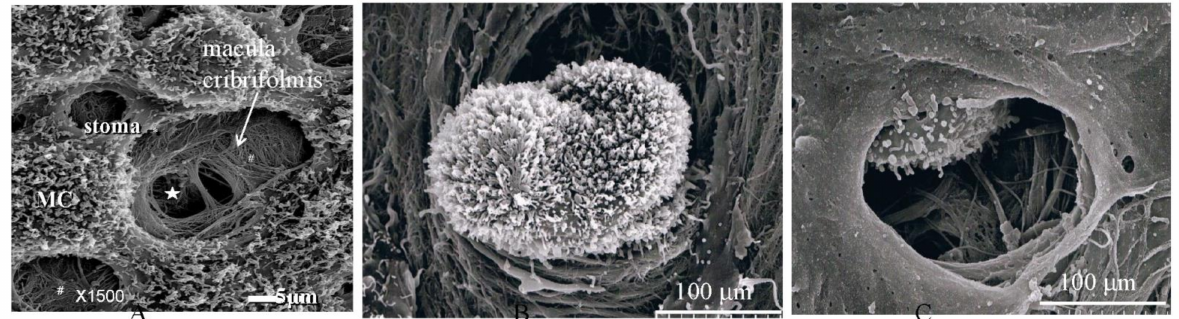
Figure 21. ( A ) Holes (*; stoma) in the macula cribriformis revealed between shrunken mesothelial cells (MC). Initial lymphatic vessels (Figure 6) exist just below the stomata. ( B ) PFCCs are attached to the stoma. ( C ) PFCC invade into the initial lymphatic vessel. Diameter of the hole of MC is 125 µ m. MC: macula cribriformis.